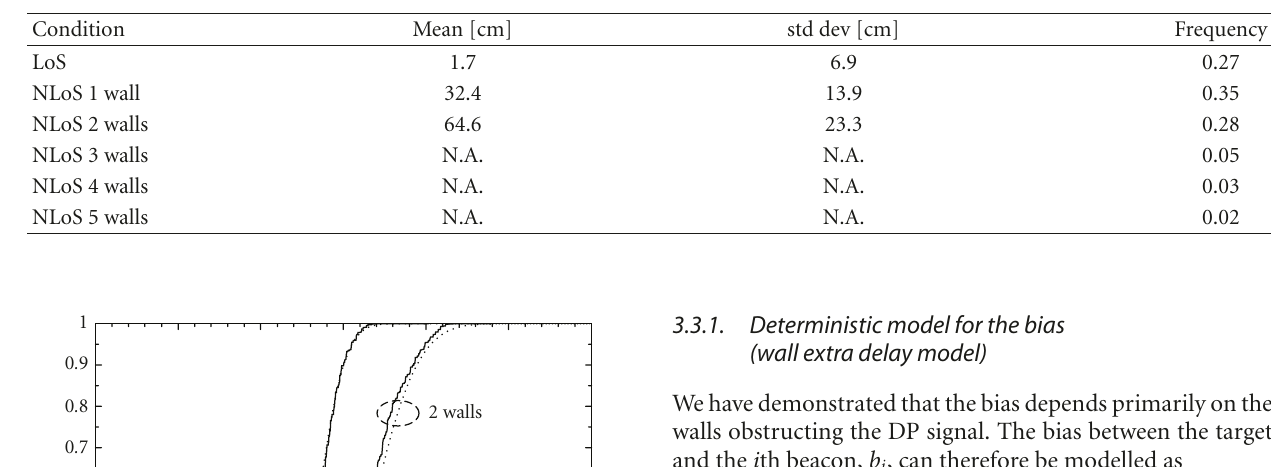
Table 2: Mean, standard deviation, and frequency for ranging error in di ff erent wall conditions.